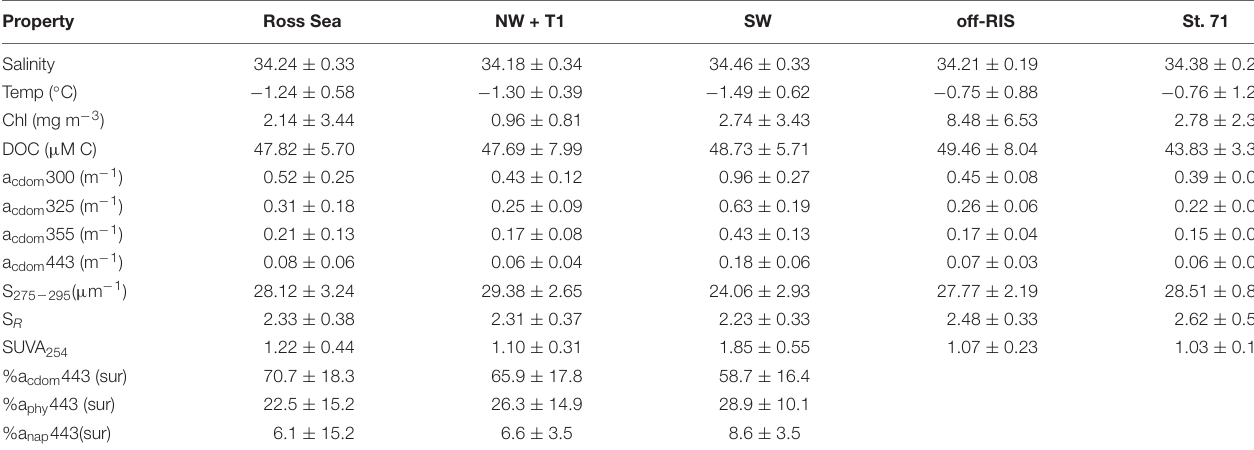
FIGURE 3 | Water column properties. Distribution of water properties (A) temperature ( ◦ C), (B) salinity and (C) chlorophyll (mg m − 3 ) along transect T1 which runs NW to SE ( Figure 1 ) and is shown as a function of latitude. (D,E) Vertical profiles of same water properties in the SW (sts 12, 15, and 25; black), off-RIS (sts 28 and 29; blue) and off Victoria Land in NW and north of the Ross Island (sts 63 and 71; green). TABLE 1 | Mean salinity, temperature, chlorophyll, DOC concentration, CDOM absorption at 300 (e.g., a cdom 300), 325, 355, and 443 nm, spectral slope S 275 − 295 , slope ratio S R , SUVA 254 ,% of total absorption coefficients at 443 nm of CDOM a cdom 443, phytoplankton a phy 443, and non-algal particles a nap 443 measured within the upper ∼ 150 m of the Ross Sea ( n = 66), that includes: the northwest and a transect inshore of the shelf break NW + T1 ( n = 45), the southwest SW ( n = 11), north of the Ross Ice shelf or off-RIS ( n = 66) and at station 71 ( n = 4); where n is the number of samples used for